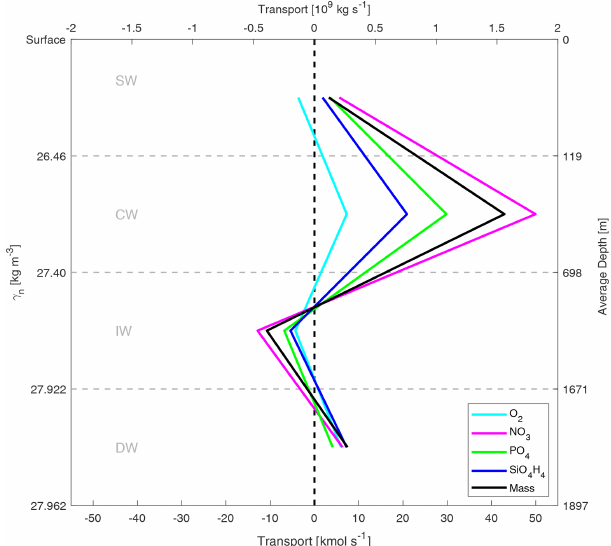
Figure 15. Mass (10 9 kgs − 1 ), O 2 , NO 3 , PO 4 and SiO 4 H 4 trans- ports (in kmols − 1 ) integrated per water-type level (SW, CW, IW and DW) through transect E during the FLUXES-I cruise. Eastward transports were defined as positive. The O 2 (PO 4 ) transport is rep- resented as being divided (multiplied) by 10. Table 3. Total imbalances of mass, O 2 , NO 3 , PO 4 and SiO 4 H 4 transports in the subtropical and tropical areas separated by the CVF at the three CW layers. All imbalances are estimated from the inte- grated transports from each respective side of the front and consid- ering transports between WOA